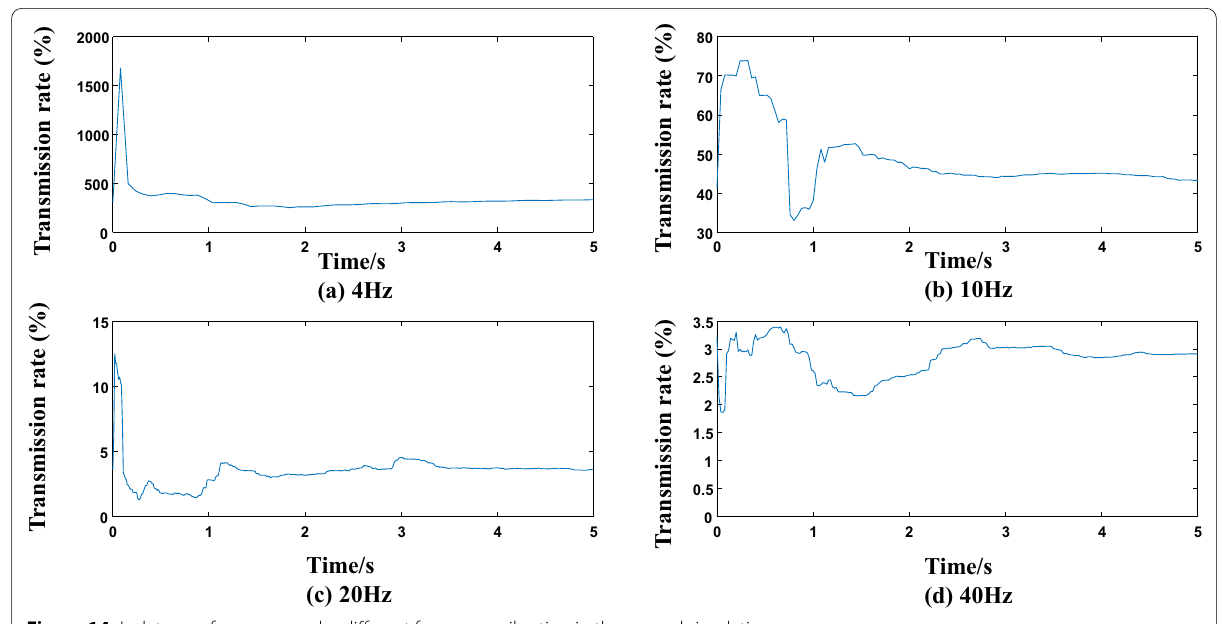
Figure 14 Isolator performance under different frequency vibration in the second